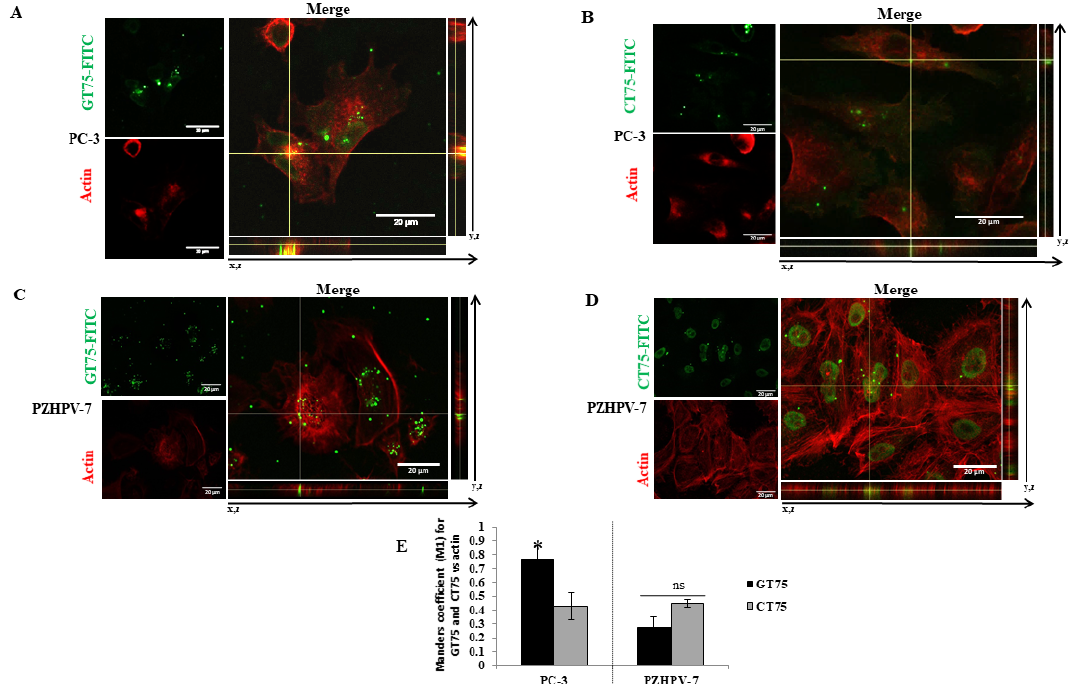
Figure 5. Evaluation of GT75 aptamer co ‐ localisation with actin bundles in PC ‐ 3 and PZHPV ‐ 7 cells. ( A – D ) Representative images of immunofluorescence confocal microscopy of GT75 ‐ FITC (( A , C ), green) and CT75 ‐ FITC (( B , D ), green) co ‐ localisation (arrows in orthogonal view) with actin protein (red), 3 h after GT75/CT75 (150 nM) transfection in PC ‐ 3 and PZHPV ‐ 7. Merge of confocal Z ‐ stack images, objective immersion oil, 60 × , bars 20 µ m. ( E ) Spatial proximity between GT75-FITC